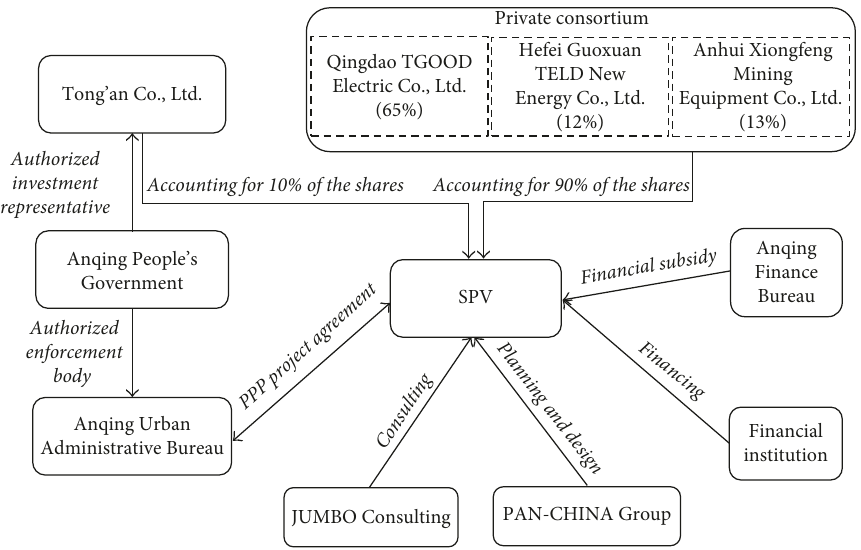
Figure 2: Project transaction